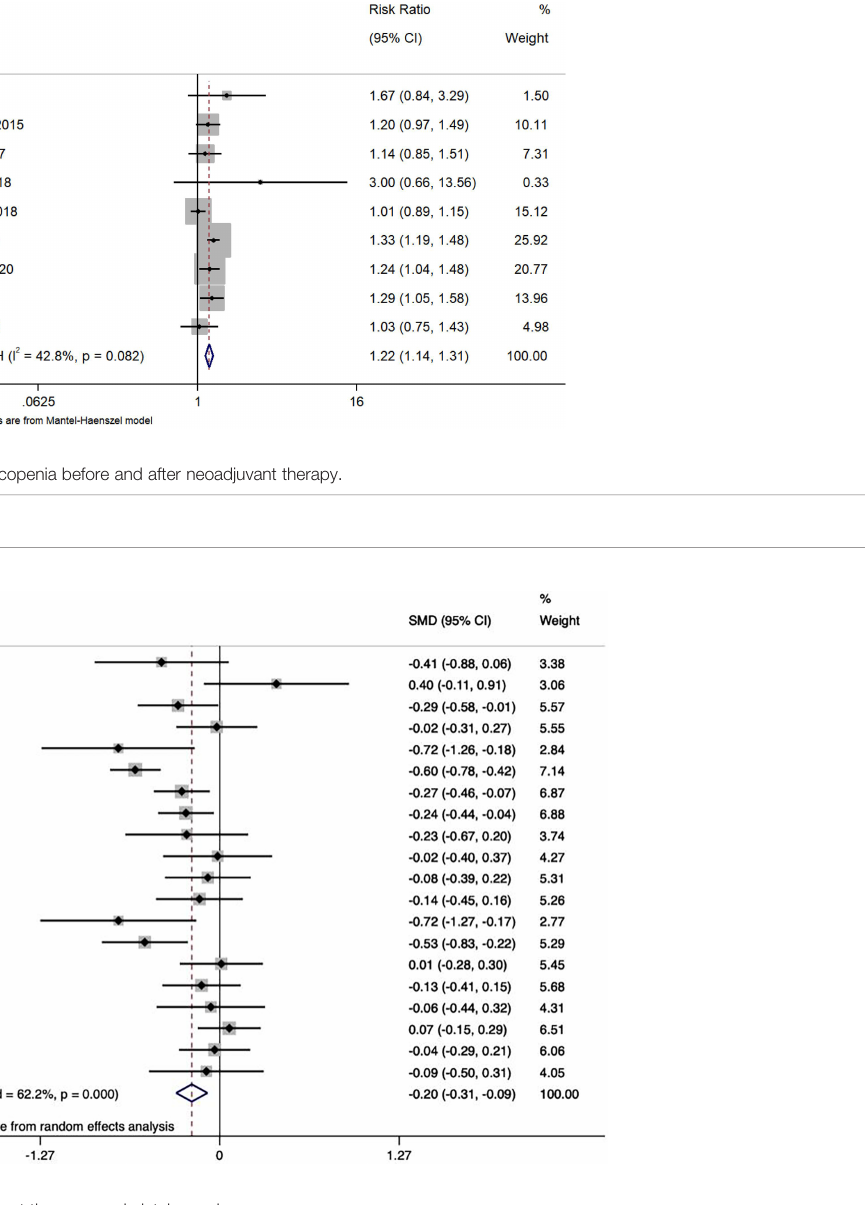
FIGURE 3 | Forest plots of the effect of neoadjuvant therapy on skeletal muscle